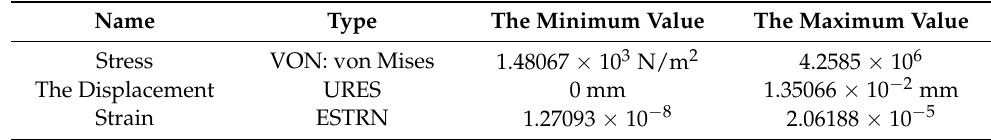
Table 4. Bottom structure statics solution parameter table.